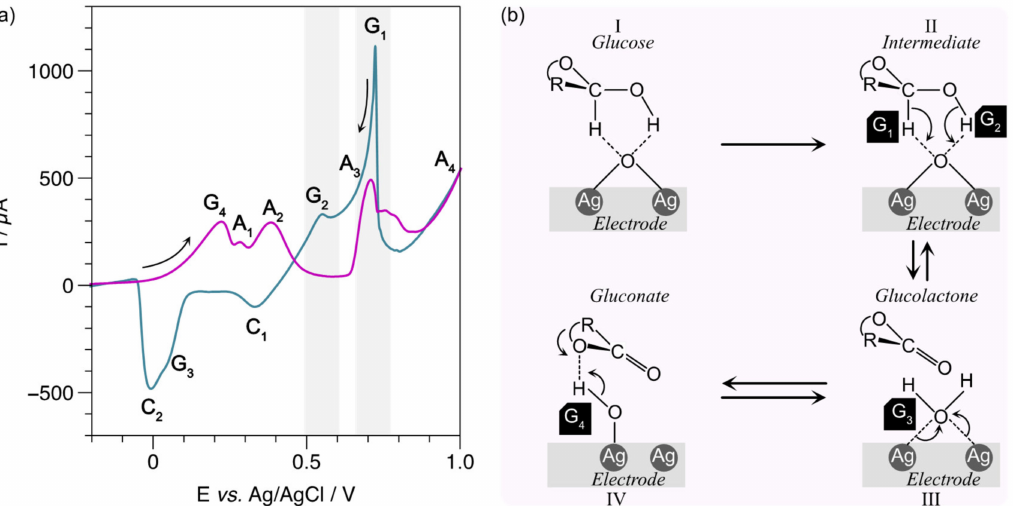
Figure 7. Exploratory analysis of glucose detection: ( a ) CV of LIG/AgNPs in the presence of 10 mM of glucose in NaOH; ( b ) proposed mechanism for glucose oxidation in LIG/AgNPs